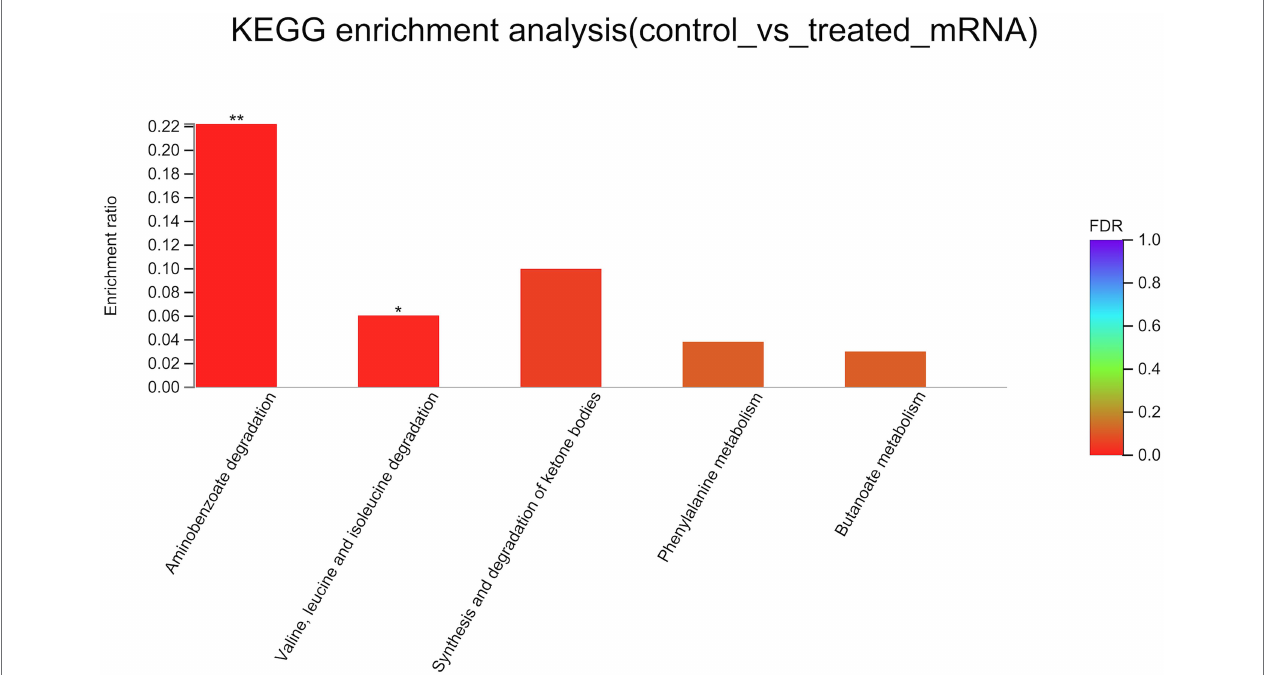
FIGURE 8 | KEGG enrichment analysis of differentially expressed genes. The x -axis represents KEGG terms, and the y -axis represents the enrichment ratio. A higher ratio means a greater degree of enrichment. KEGG, Kyoto Encyclopedia of Genes and Genome. FDR , false discovery rate. * FDR < 0.05 , ** FDR < 0.01 .